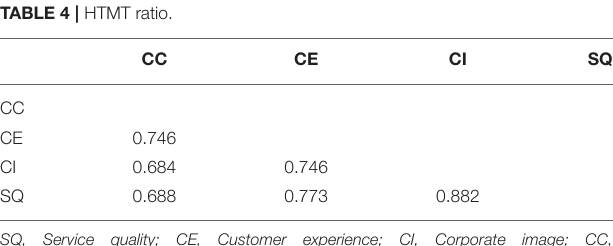
TABLE 4 | HTMT ratio.